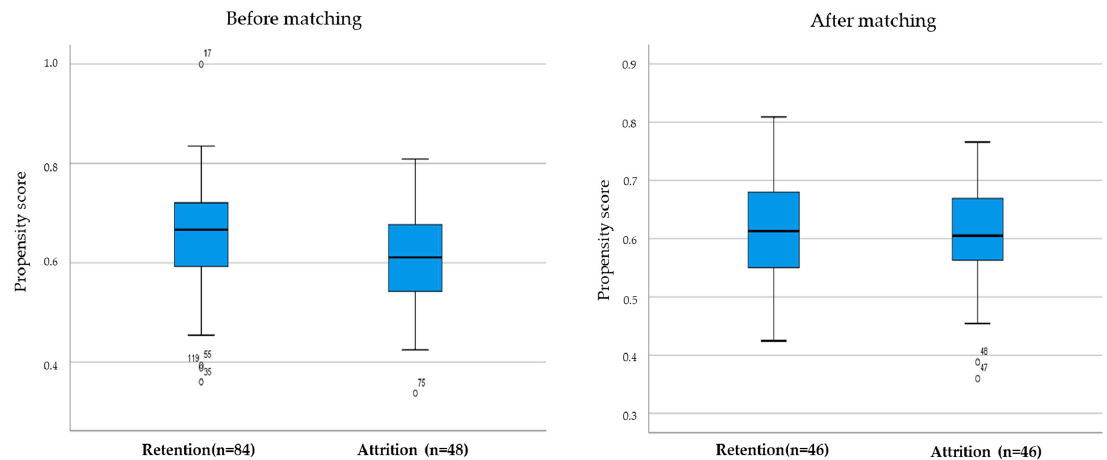
Figure 1. Comparison of propensity score retention and attrition.